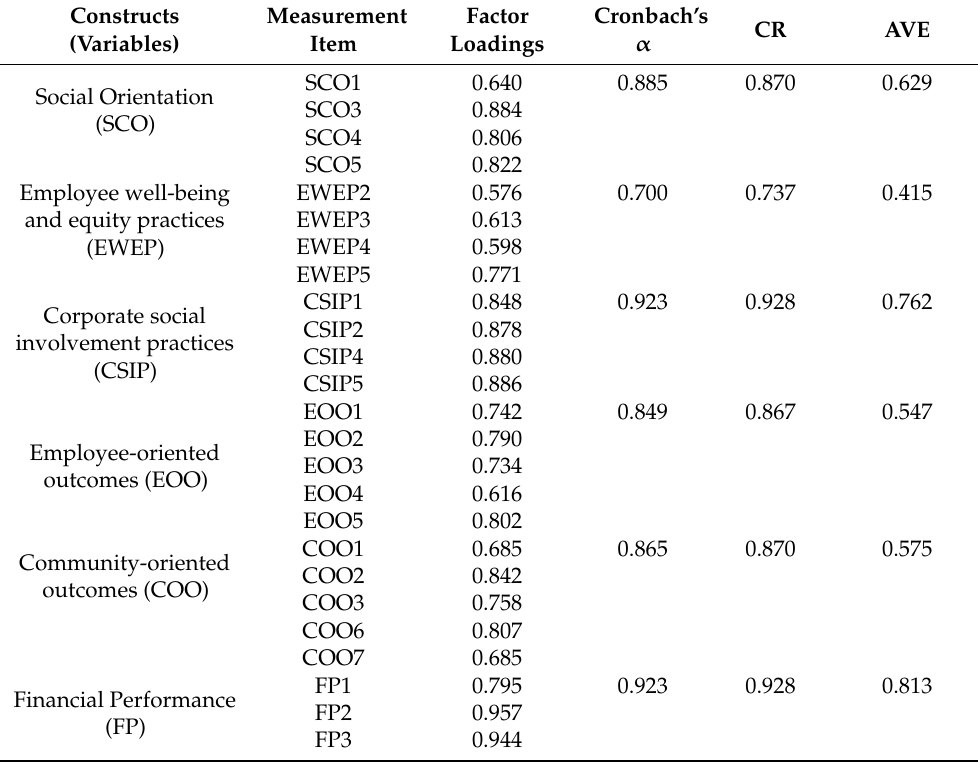
Table 1. Measurement model item loadings and reliability.